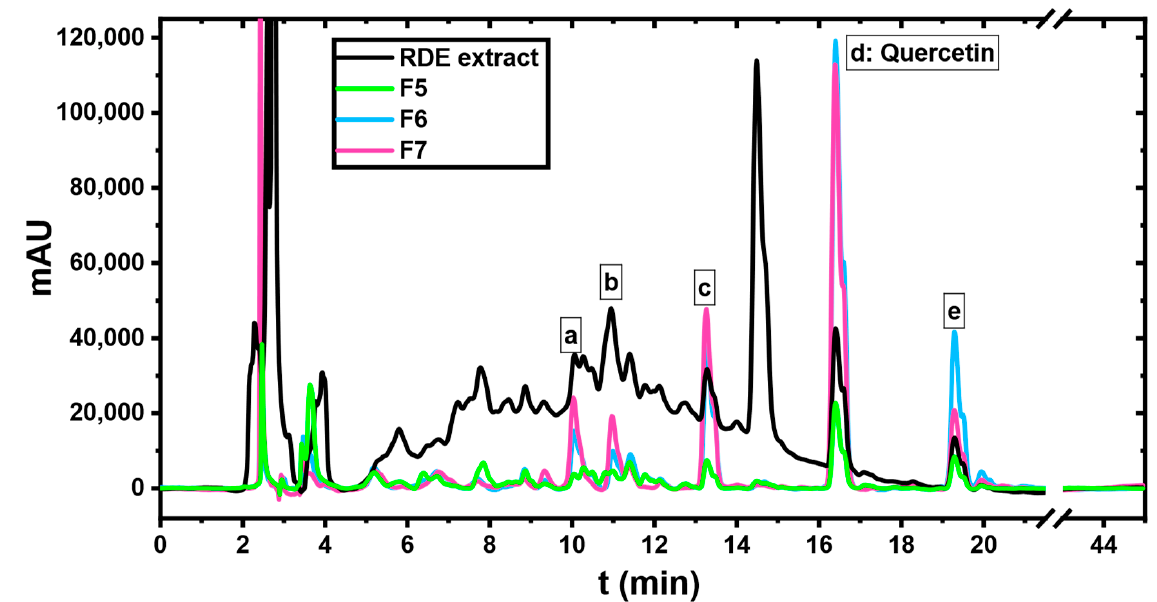
Figure 8. Chromatograms of RDE and fractions 5, 6 and 7 (abbreviated F5, F6 and F7).